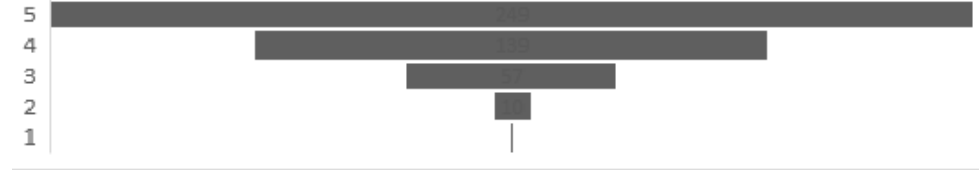
Figure 1. Quantitative distribution of responses subjectively assessing patient satisfaction with e-prescribing.